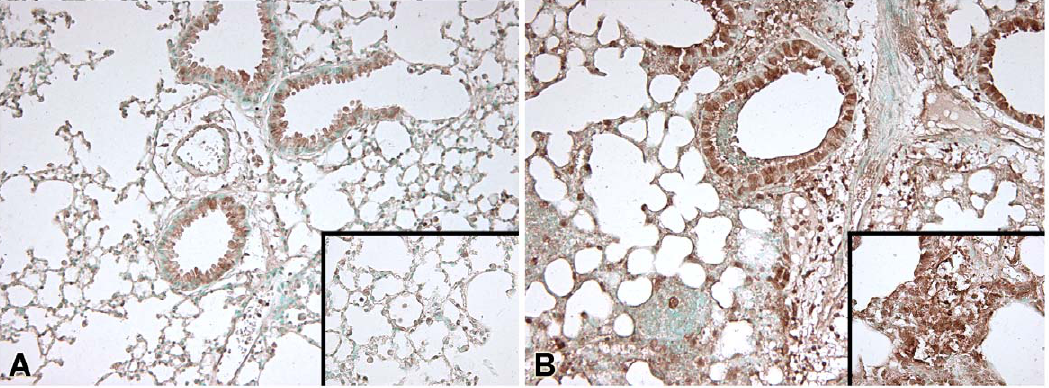
Figure 3. Immunostaining for MIF in the lungs of mice. Positive immunostaining for MIF in lung tissue was observed in non-infected control animals of bronchial epithelial cells and alveolar macrophages ( A ). 48 hours after infection with B. pseudomallei there was a marked increase in immunostaining of the epithelial submucosa, bronchial epithelial cells and inflammatory cells, most notably of alveolar macrophages ( B ). Magnification 6 10, insets 6 20.